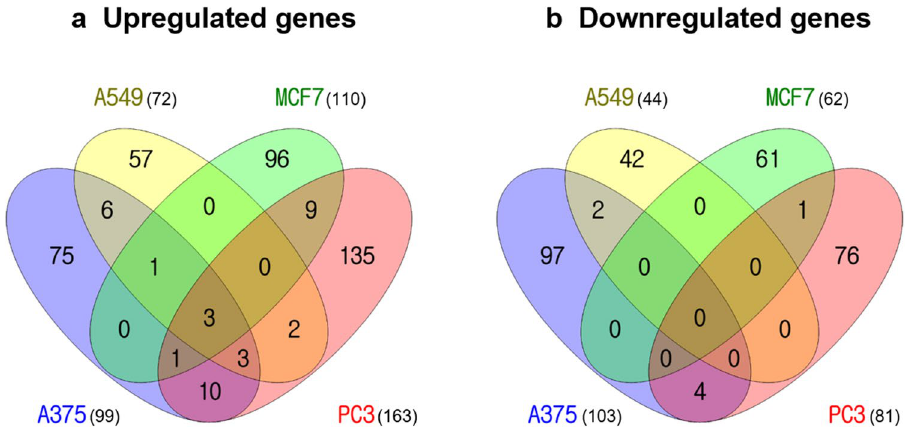
Figure 2. Venn diagram for the differentially expressed gene (DEG) lists in four cell lines. ( a ) Upregulated genes and ( b ) downregulated genes. The crossing areas show the commonly changed DEGs. Statistically significant DEGs were defined using p < 0.05 and |FC| ≥ 1.5 as cut-off. Venny website was used for drawing Venn diagrams (https:// bioin fogp. cnb. csic. es/ tools/ venny/ index.